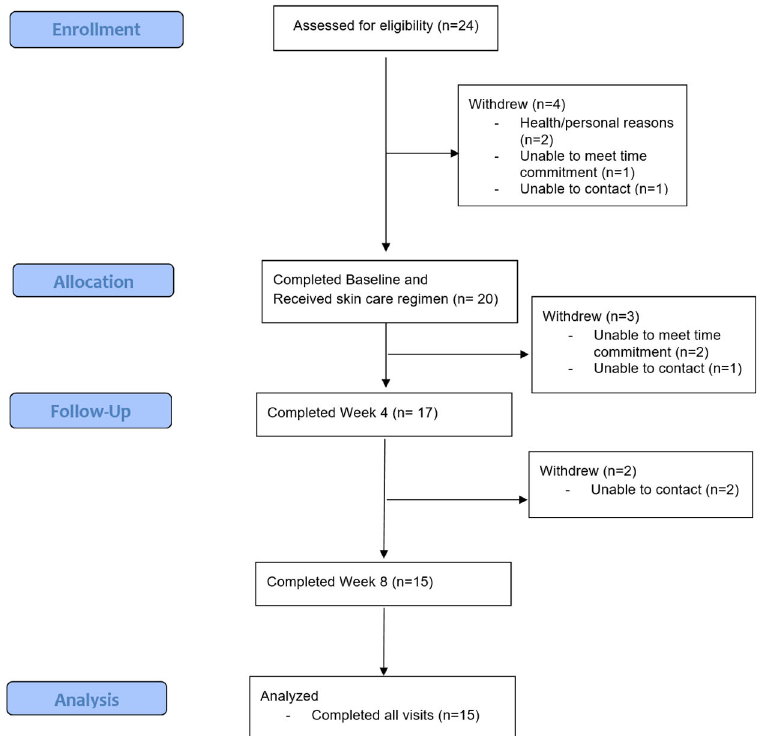
Figure 1. CONSORT (Consolidated Standards of Reporting Trials) flow diagram.